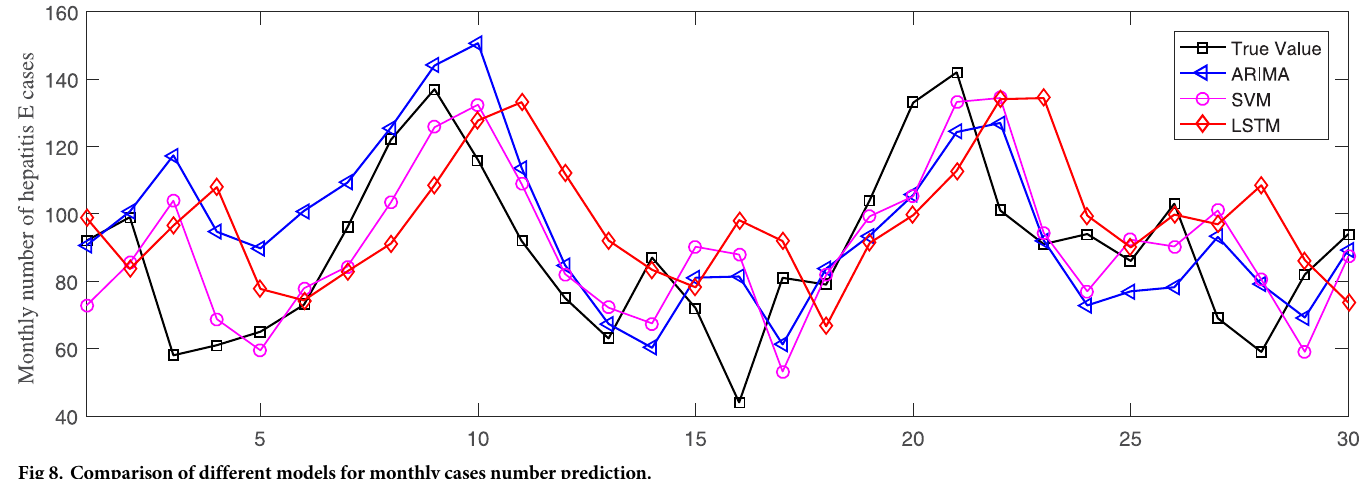
Fig 8. Comparison of different models for monthly cases number